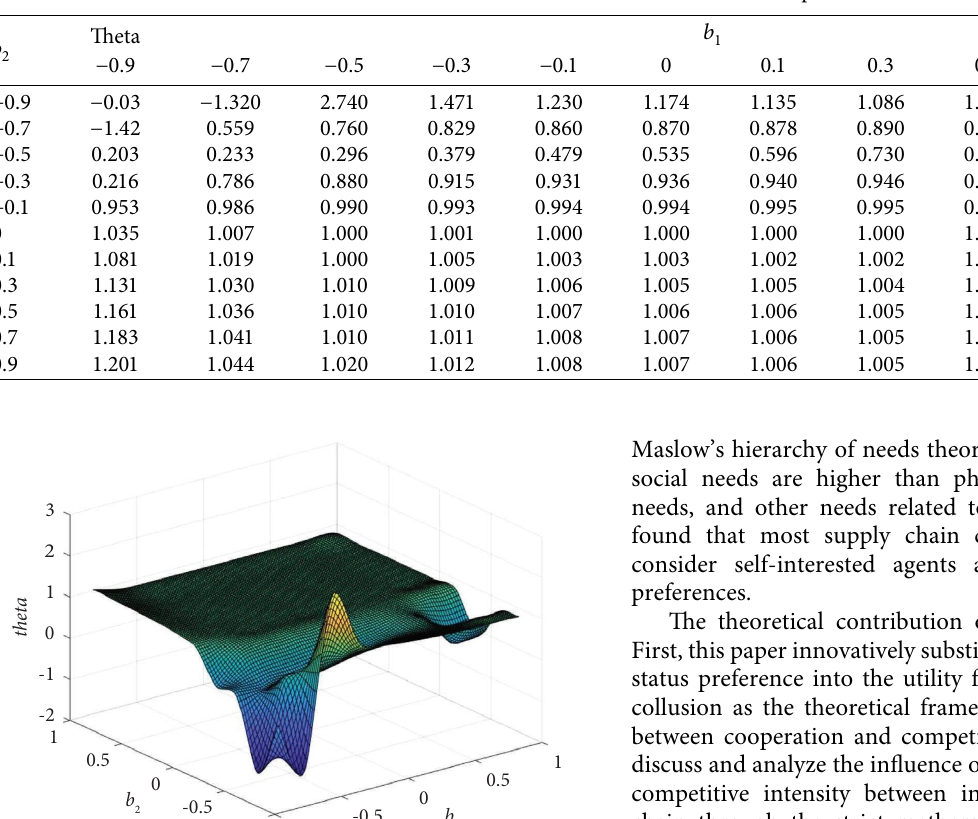
Table 3: Te critical discount varies with the status